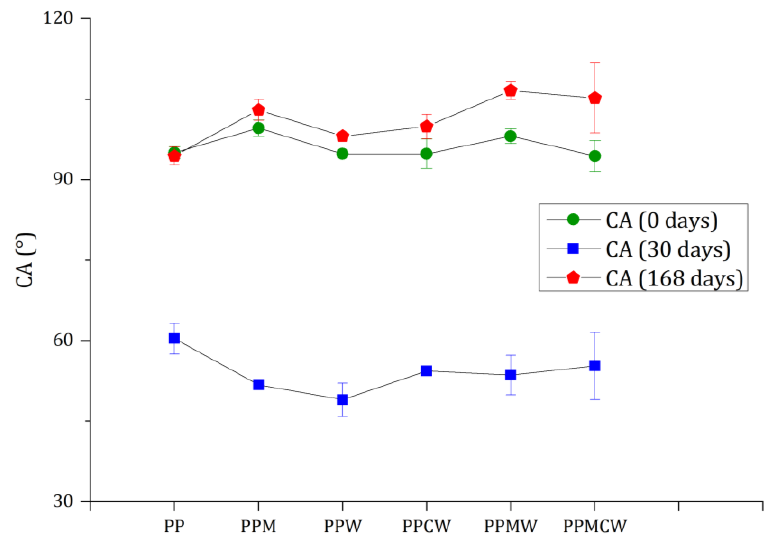
Figure 4. Water contact angle (CA) values of samples before (0 days), after natural (168 days), and accelerated (30 days) aging.